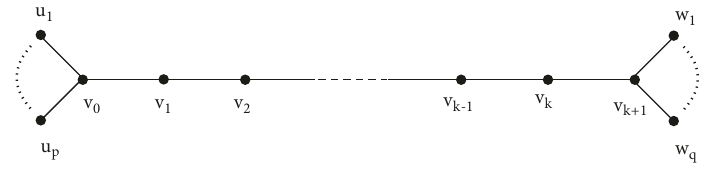
Figure 4: The shape of a special kind of caterpillars.